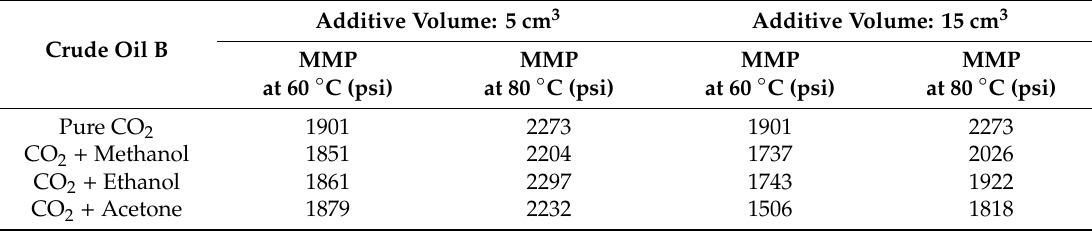
Table 5. Summary of MMP for crude oil B with the additive volumes and